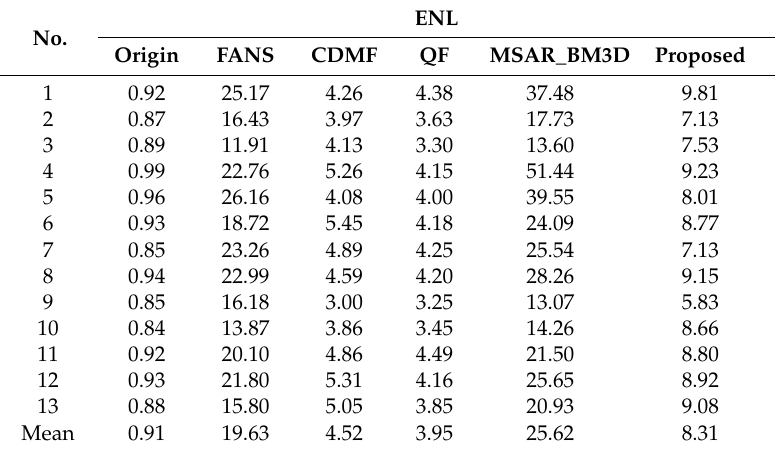
Table 3. The quantitative comparison of different filtering results for Dataset 1, using equivalent number of looks